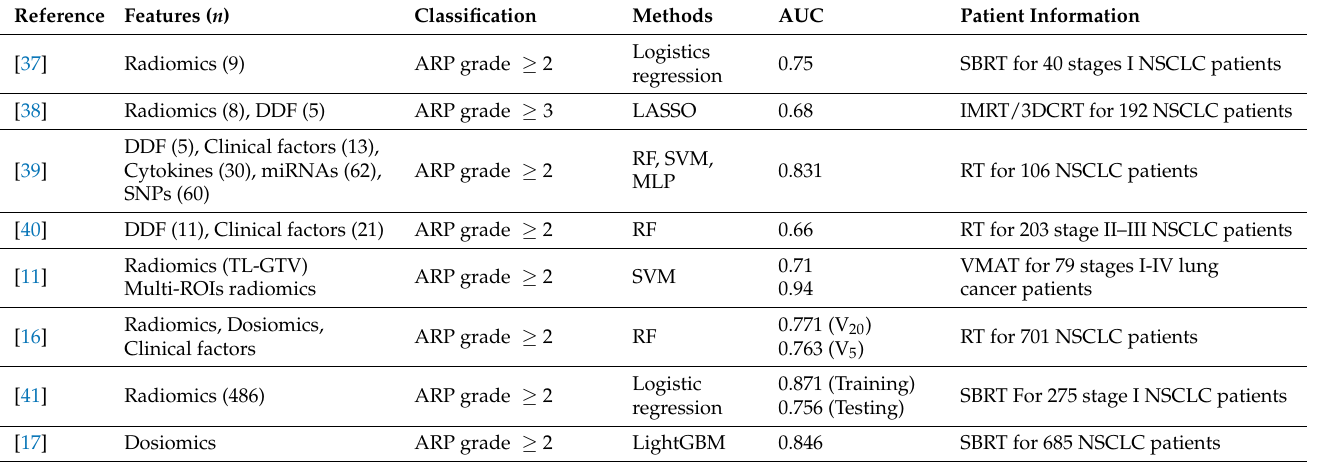
Table 3. The previous studies for predicting the ARP using single or multiple omics features for lung cancer patients treated with